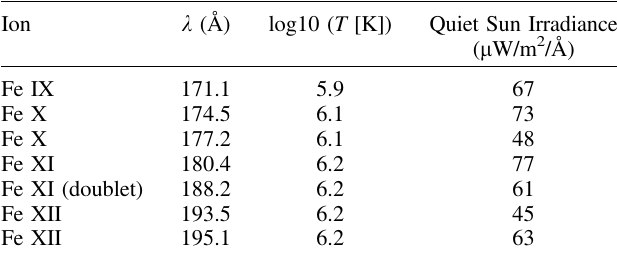
Table 1. Strong emission lines in the SunCET bandpass. Irradiance measured by SDO/EVE (Woods et al., 2012).